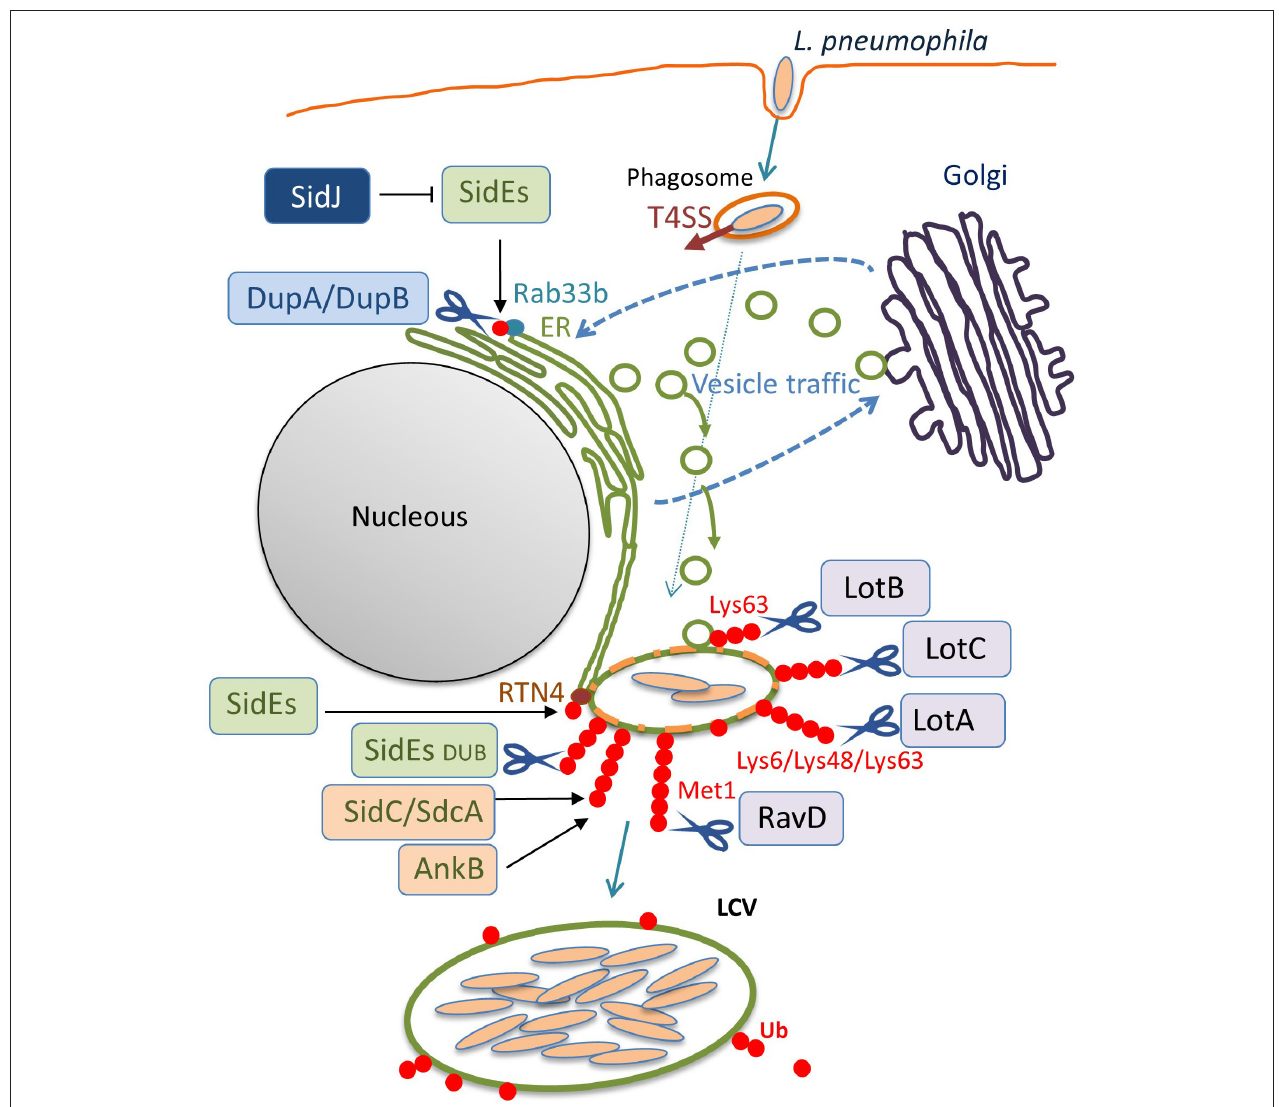
FIGURE 2 | The ubiquitin system-modulating L . pneumophila effectors that are associated with LCV biogenesis. Once inside the host cell, L . pneumophila intercepts membrane traffic between the ER and the Golgi apparatus to acquire secretory vesicles to form the LCV. Among the L . pneumophila effector proteins delivered via the Dot/Icm T4SS, many enzymes associate with the LCV and catalyze ubiquitination, deubiquitination, or reactions that modulate the function of other effectors. In addition to the conventional ubiquitin ligases SidC, SdcA (Luo and Isberg, 2004; Ragaz et al., 2008; Hsu et al., 2014; Wasilko et al., 2018), and AnkB (Price et al., 2009, 2011), the unconventional ubiquitin ligases SidEs have been found to associate with the LCV. SidEs conjugate PR-Ub to many host proteins that function in the secretory pathway, such as Rab33b and RTN4, to modulate their functions. DupA and DupB remove the SidEs-conjugated PR-Ub from substrates with their DUB activity. SidJ negatively regulates the function of SidEs, using its enzymatic activity to modify the active site of SidEs. The amount of ubiquitin on LCVs can be reduced by the function of the bacterial DUBs LotA, LotB, LotC, and RavD. These can localize to the LCV and execute their function on the LCV, depending on their catalytic activities to cleave distinctive linkage-type ubiquitin chains. SidEs also act as canonical DUBs to remove ubiquitin from the